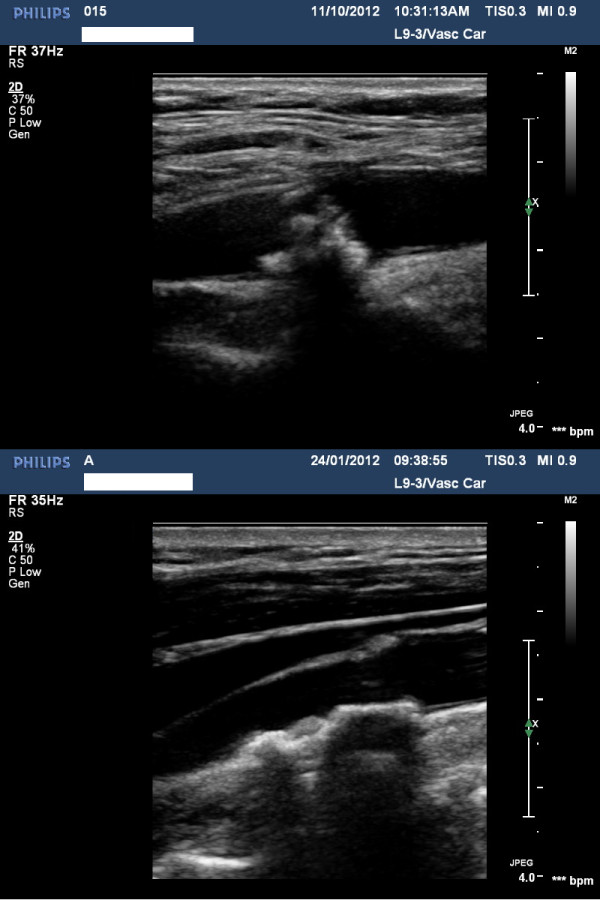
Full-size ultrasound images corresponding to the close-up plaque views shown in Figure 1. (top row) the symptomatic plaque, (bottom row) the asymptomatic plaque.